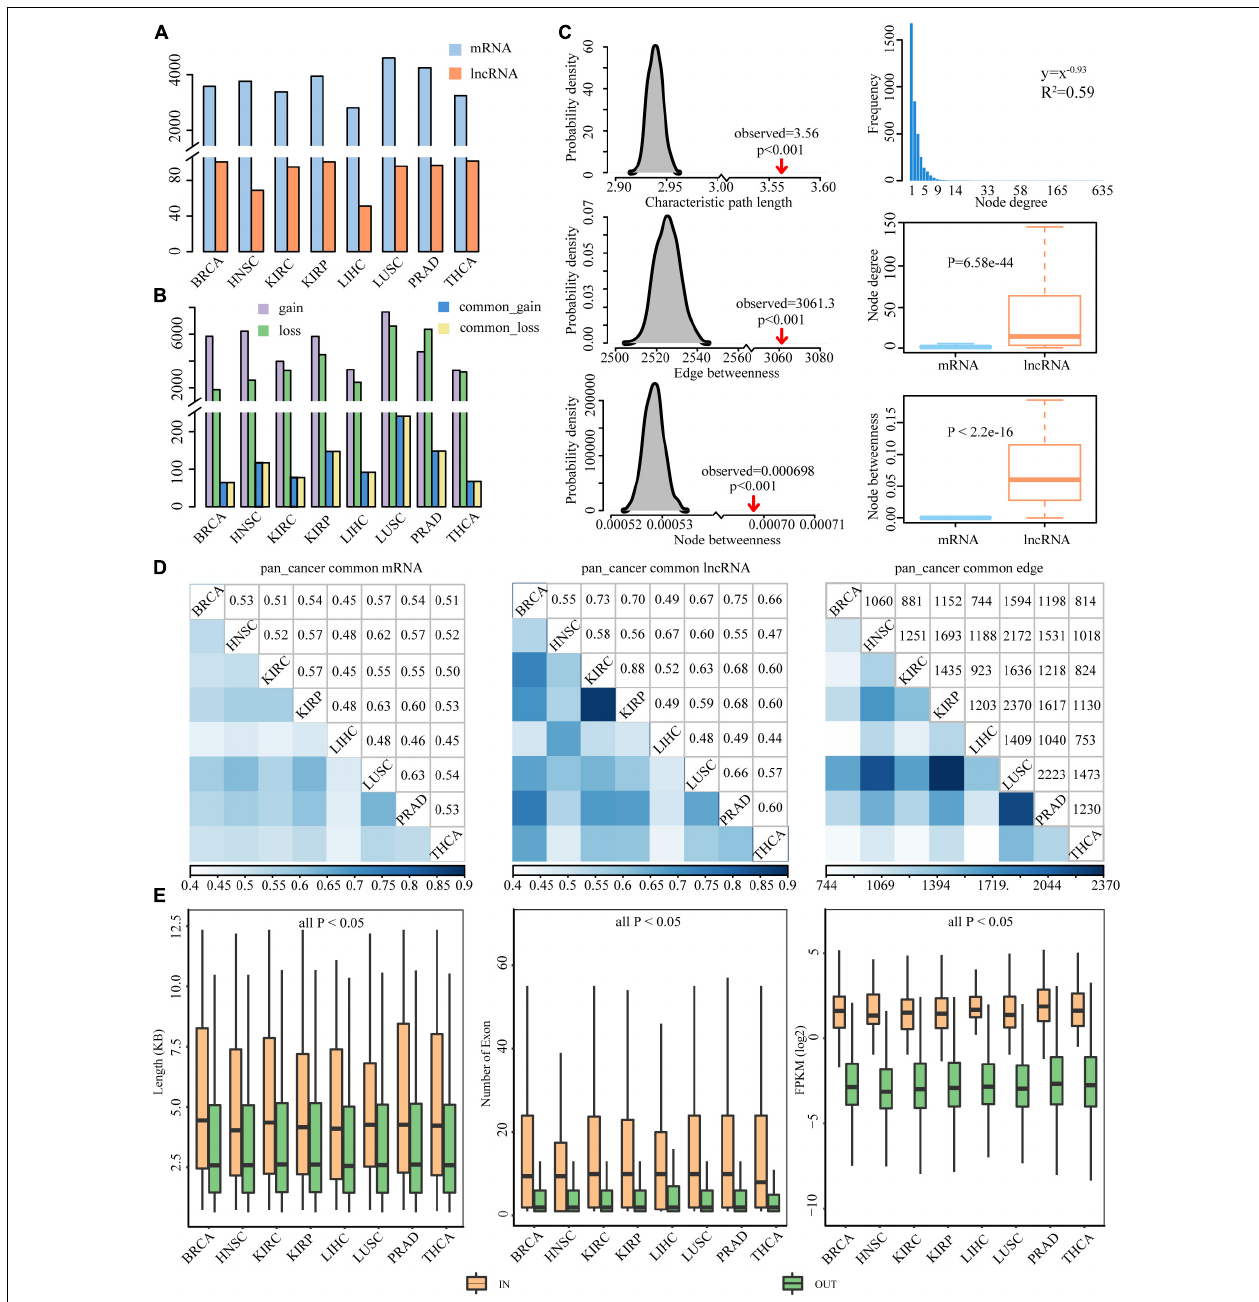
FIGURE 3 | Property features of DysCeNets across eight cancer types. (A) The number of mRNA and lncRNA in DysCeNets. (B) The number of gain and loss interactions in DysCeNets. A purple column represents ceRNA pairs that specifically existed in cancer samples, a green column represents ceRNA pairs that specifically existed in normal samples, and blue and yellow columns represent upper and lower quarters of common ceRNA pairs. (C) The characteristic path length, average edge betweenness, and average node betweenness of DysCeNets compared to random networks are shown in the left panel. The distribution of node degree, the differences of node degree, and betweenness between mRNA and lncRNA are shown in the right panel. (Take BRCA as an example, the other cancer properties are shown in Supplementary Figure 1 .) (D) The comparison of mRNAs, lncRNAs, and edges between any two cancer types. (E) The length, number of exons, and expression level of lncRNAs in the DysCeNets compared with lncRNAs not involved in the